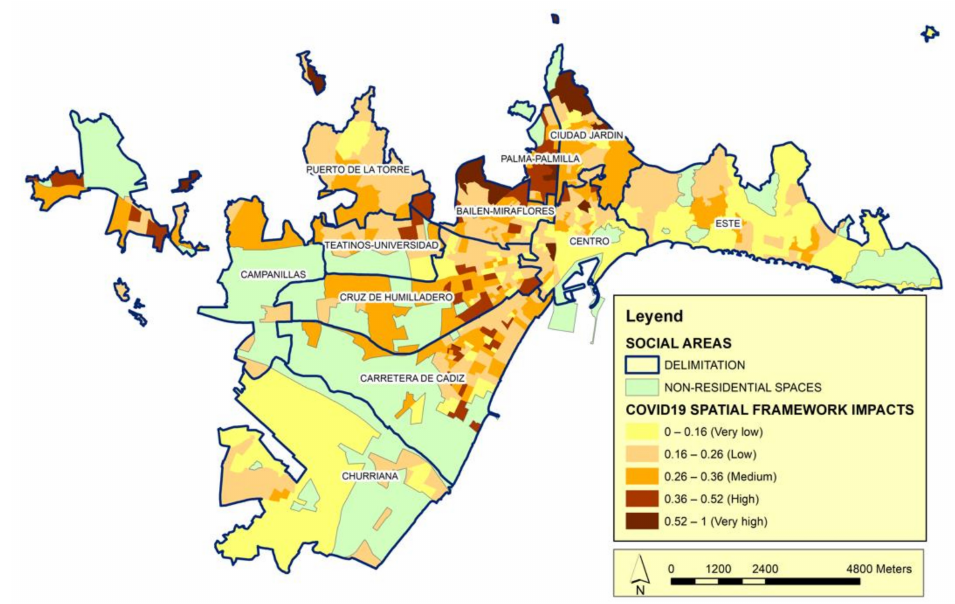
Figure 8. Distribution of the impact of COVID-19 according to the Spatial Framework category. Source: Author’s elaboration. The impact index shows the correlation between Spatial Framework vulnerability calculated according to the variables of this category in relation to the number of